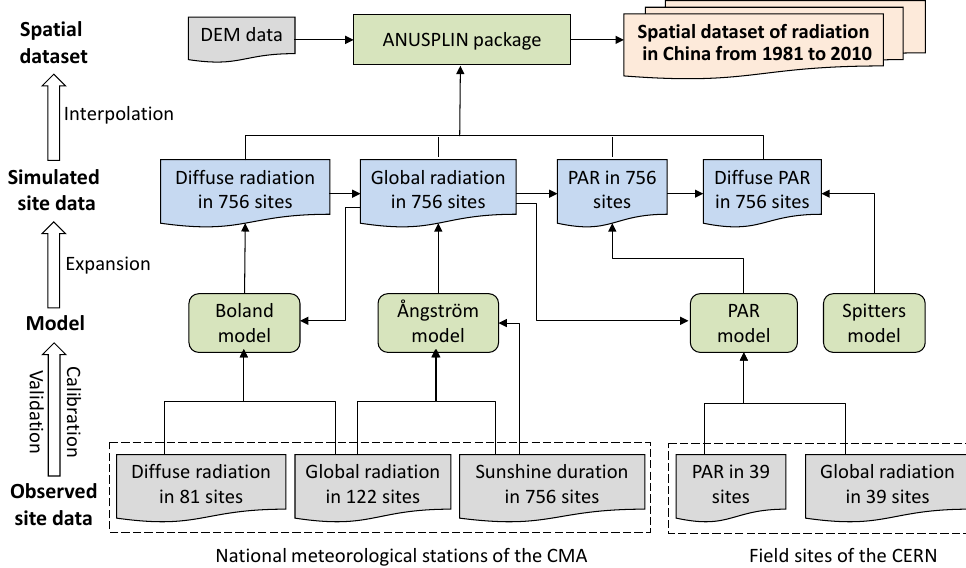
Figure 1. The schematic workflow of the radiation dataset